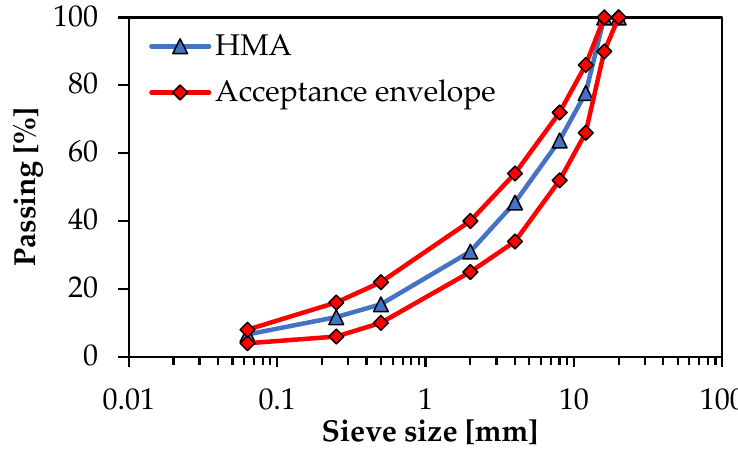
Figure 1. HMA gradation. Table 3. Characteristics of the virgin bitumen.